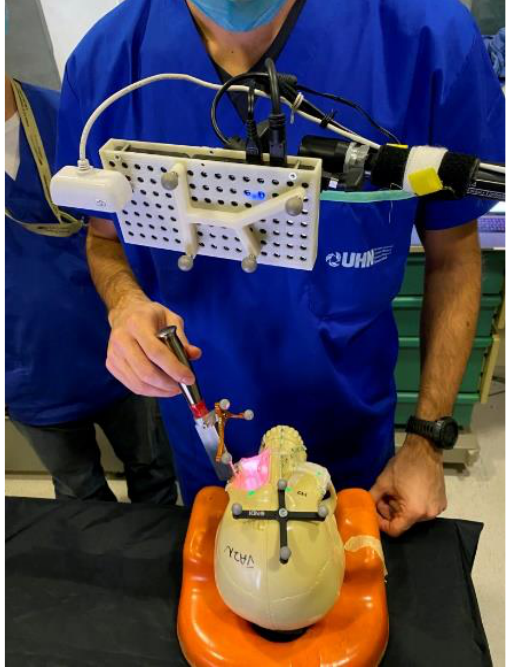
Figure 3. Augmented reality system mounted and